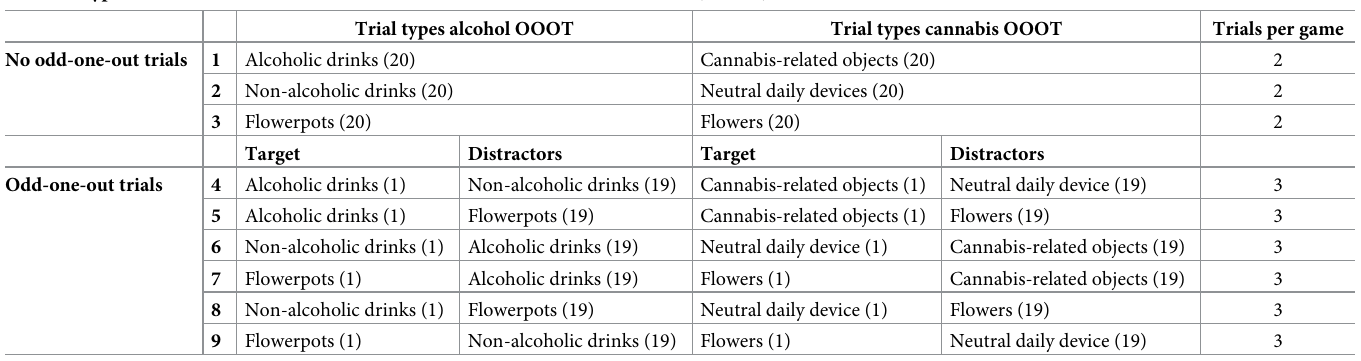
Table 1. Type and number of trials in the alcohol and cannabis Odd-One-Out Task